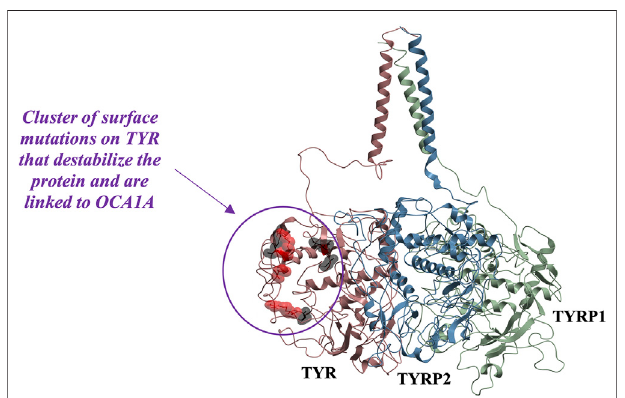
FIGURE 5 | Cluster of mutations associated with ER retention map to a contiguous surface of the protein, suggesting a new interaction site with an unknown binding partner. R403, R402, P406L, R422, D448, and G446 map onto the surface of the protein in the region located distant from the active site. Substitutions shown in red (R402Q, P406L, and R422Q) result in temperature-sensitive TYR mutants.